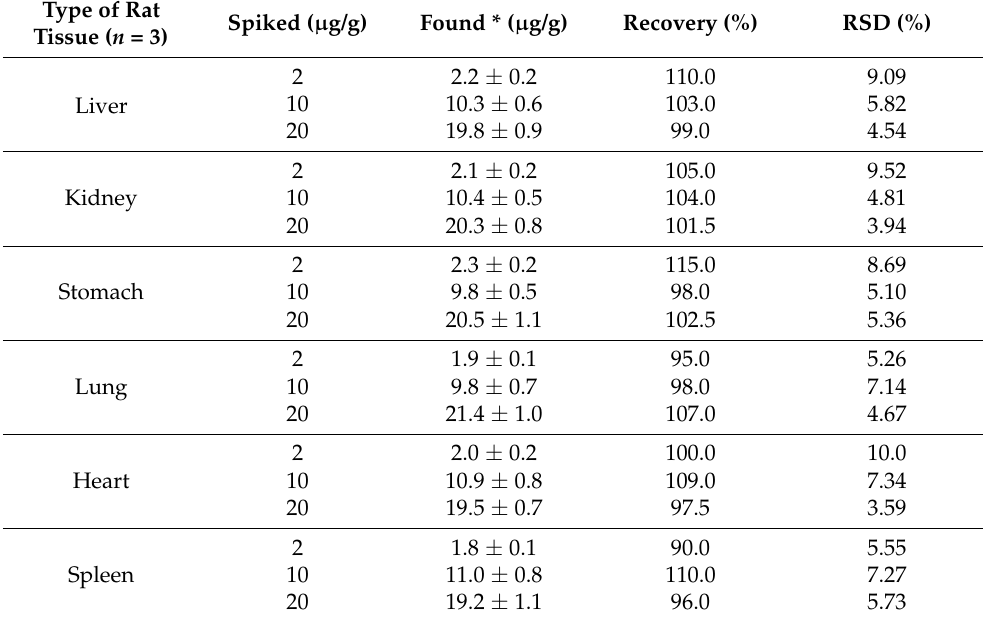
Table 5. Measurement of DOX in different rat tissue samples ( n = 3 for each tested tissue